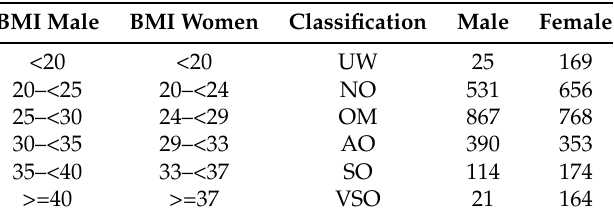
Table 2. Classification of BMI per